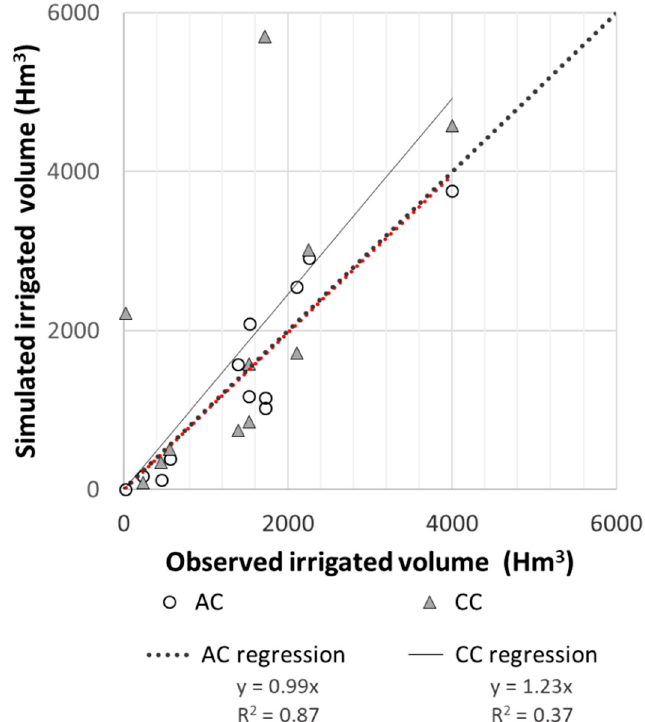
Figure 5. Simulated additional calibration (AC) versus observed annual water volume (Hm 3 ) used in irrigation for each Spanish region (inter-annual averages from 2000 to 2010).